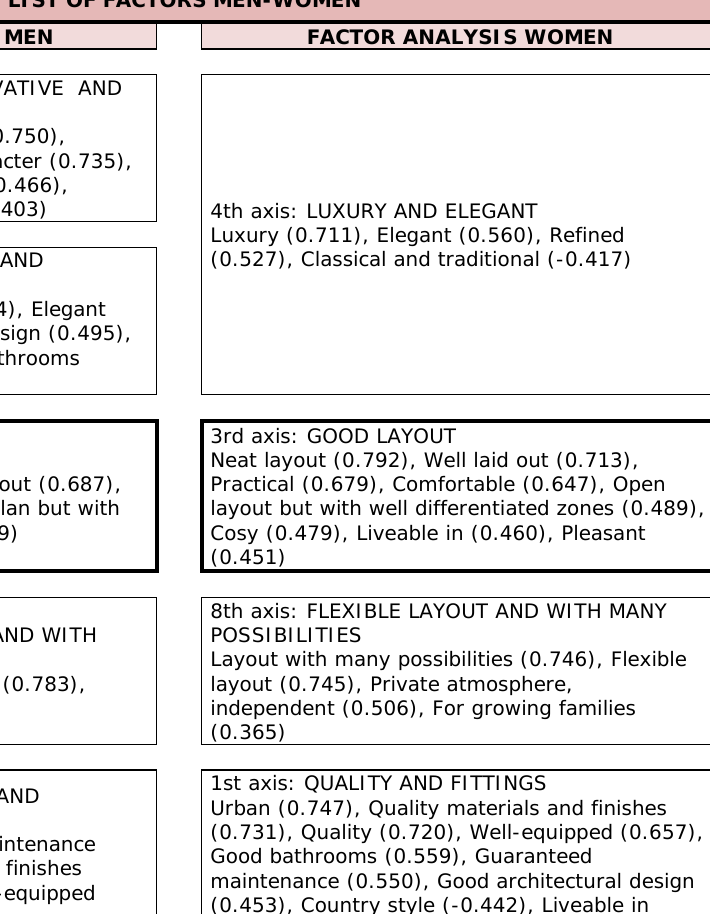
1st axis: QUALITY AND FITTINGS Urban (0.747), Quality materials and finishes